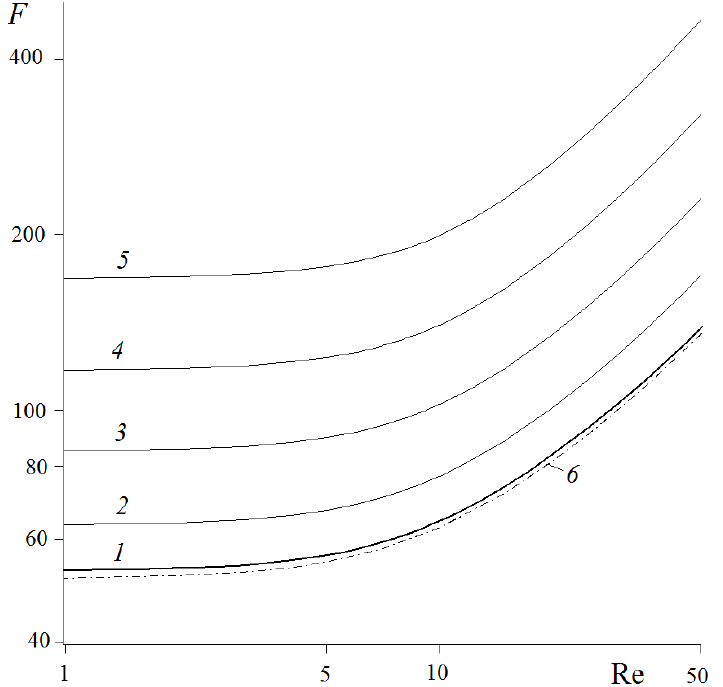
Figure 2. Dimensionless drag forces per unit length of profiled fibers with parallel rectangular protrusion obstacles (curves 2 – 5 ) with a protrusion thickness of 0.1 and a protrusion height of 0.1 ( 2 ), 0.2 ( 3 ), 0.3 ( 4 ), 0.4 ( 5 ), solid curve 1 —smooth fiber; dashed-dotted curve 6 —a fiber with parallel grooves with width and depth equal to 0.1 and 0.4; 𝑎 ℎ ⁄ = 0.5.